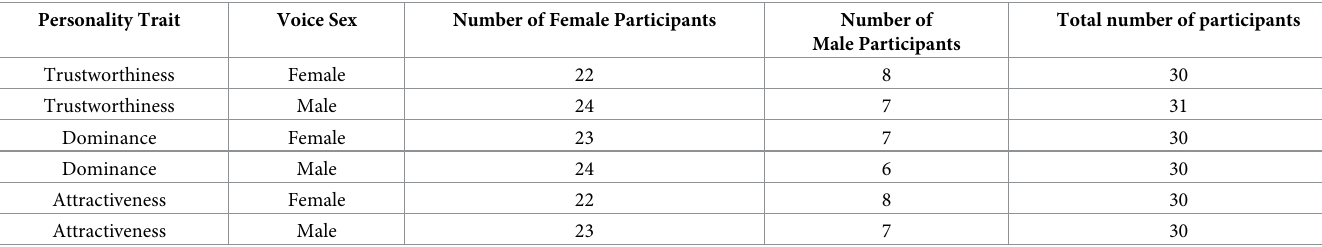
Table 2. Number of female and male participants separated by personality trait and voice sex. Personality